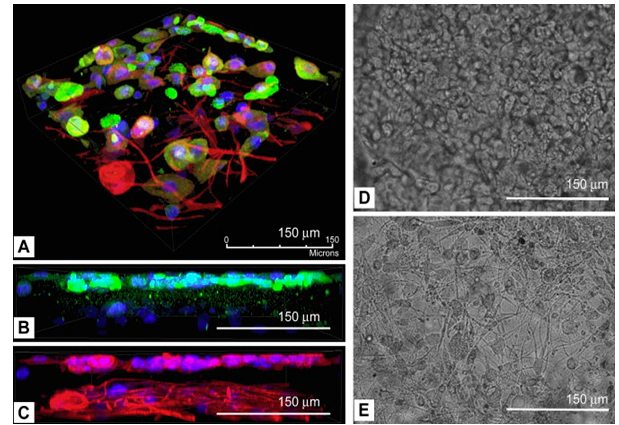
Figure 3. Confocal images of multi-layered printing of fibroblast and keratinocytes (FB and KC) on the cell culture dish. ( A ) Z stacking using immunofluorescent images showed interlayer distance ~75 µm was observed. ( B,C ) keratin-containing KC layer and β -tublin-containing KC and FB. Bright-field images on ( D ) KC layer and ( E ) FB layer also confirmed the immunohistochemistry